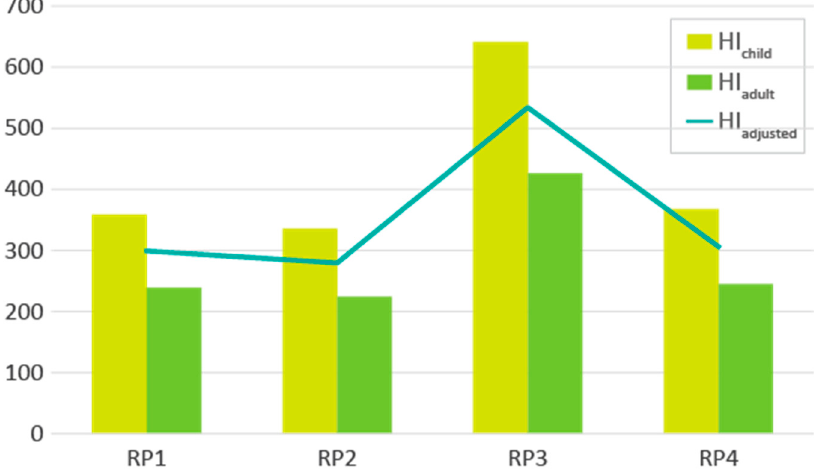
Figure 7. Hazard index in edible plants.